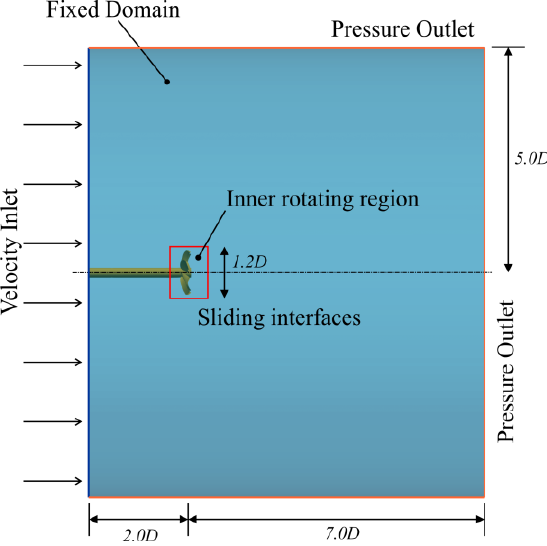
Figure 2. Computational domain and boundary conditions. Table 2. Boundary conditions for OpenFOAM calculations.